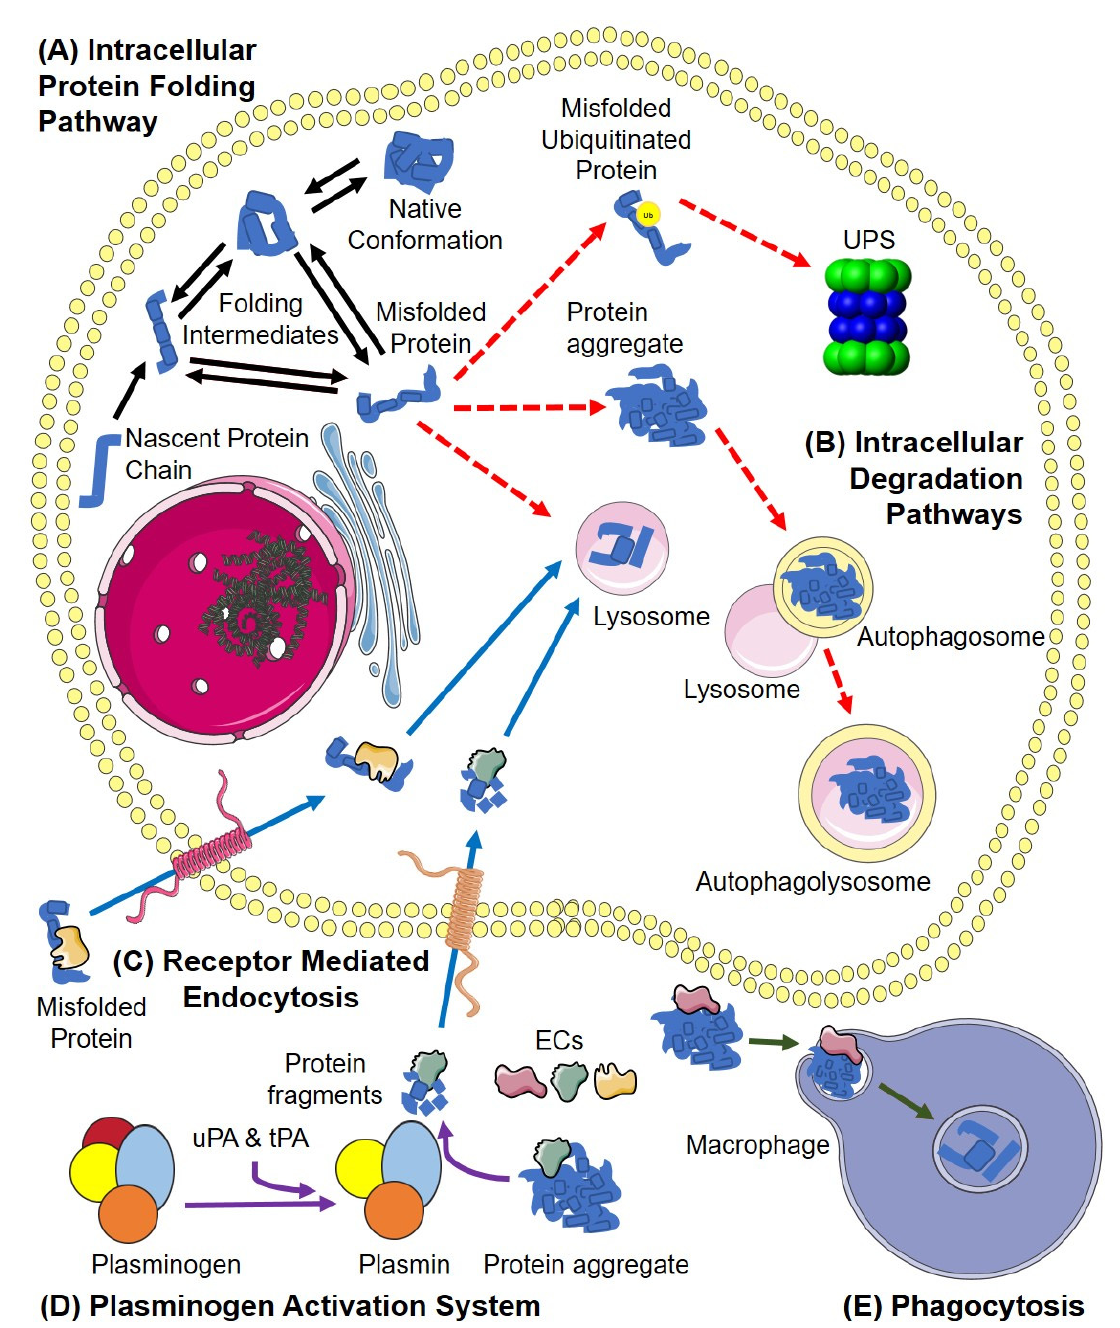
Figure 1. Intra- and Extracellular Proteostasis. ( A ) Intracellularly, proteins need to fold from nascent polypeptide chains into their native conformation (black arrows). If a protein intermediate reaches a misfolded state, and is not rescued by chaperones, it may aggregate (dashed red arrow). ( B ) Large insoluble protein aggregates can be removed via autophagy (digested in autophagolysosomes; dashed red arrow). Alternatively, misfolded proteins may be ubiquitinated and degraded by the ubiquitin-proteasome system (UPS; dashed red arrow). ( C ) Extracellularly, misfolded proteins bound by extracellular chaperones (ECs) are internalised by receptor-mediated endocytosis (RME) and trafficked to lysosomes for degradation (solid blue arrows). Extracellular protein aggregates may be ( D ) digested by the plasminogen activation system (PAS; purple arrows), and the protein fragments generated are bound by ECs also directed for RME and lysosomal degradation (blue arrows) or ( E ) phagocytosed and digested intracellularly (green arrows). Abbreviations: UPS, ubiquitin proteasome system.